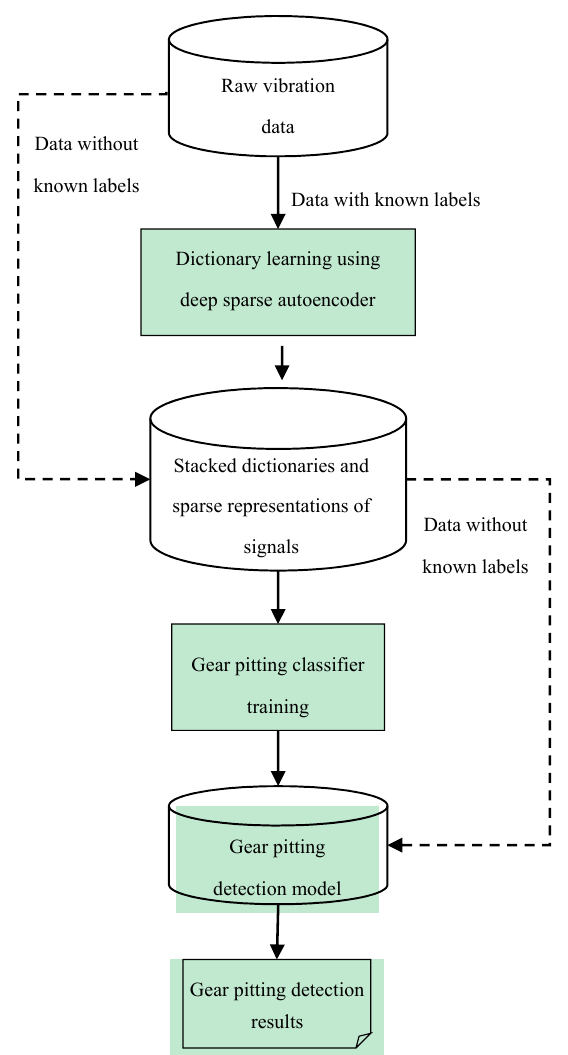
Figure 1. General procedure of the deep sparse autoencoder-based gear pitting detection.